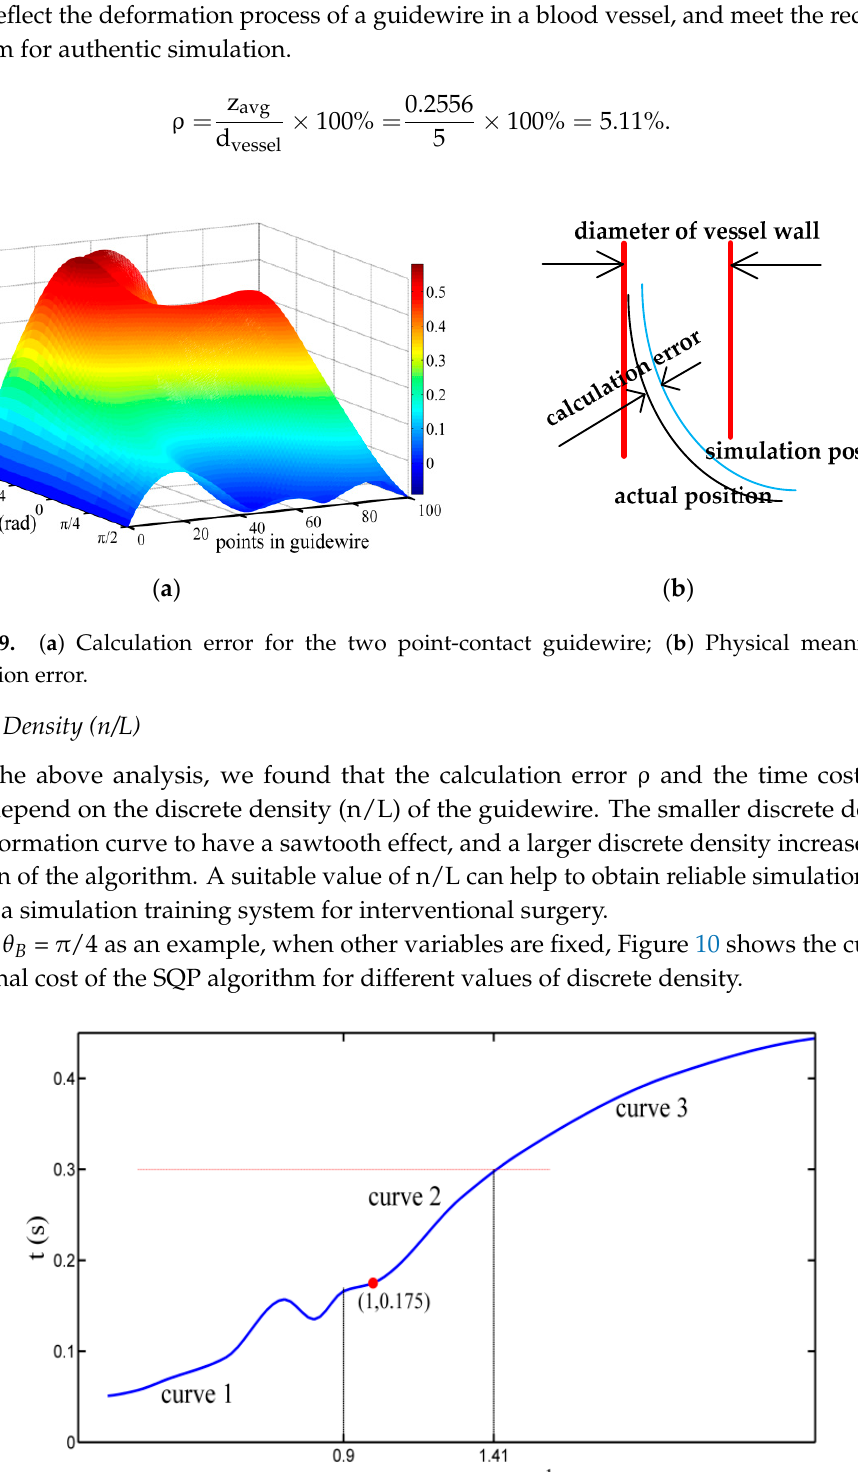
10 of 16 Figure 8. Comparison of the optimized deformed shape of the two point-contact guidewire computed via sequential quadratic programming (SQP) optimization or by ABAQUS. If (h i , q i ) represents the coordinates of each point on the deformation curve obtained by the SQP algorithm, and (F i , Q i ) represents the coordinates of the corresponding point obtained by the ABAQUS simulation. Hence, the plane distance between the two results can be expressed by Equation (25), which is the error between the results of SQP algorithm and the result of ABAQUS simulation.